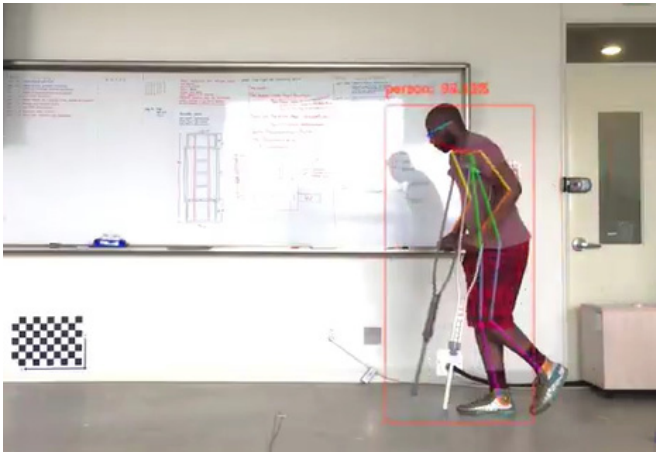
Figure 2. OpenPose output of one of the participants walking with